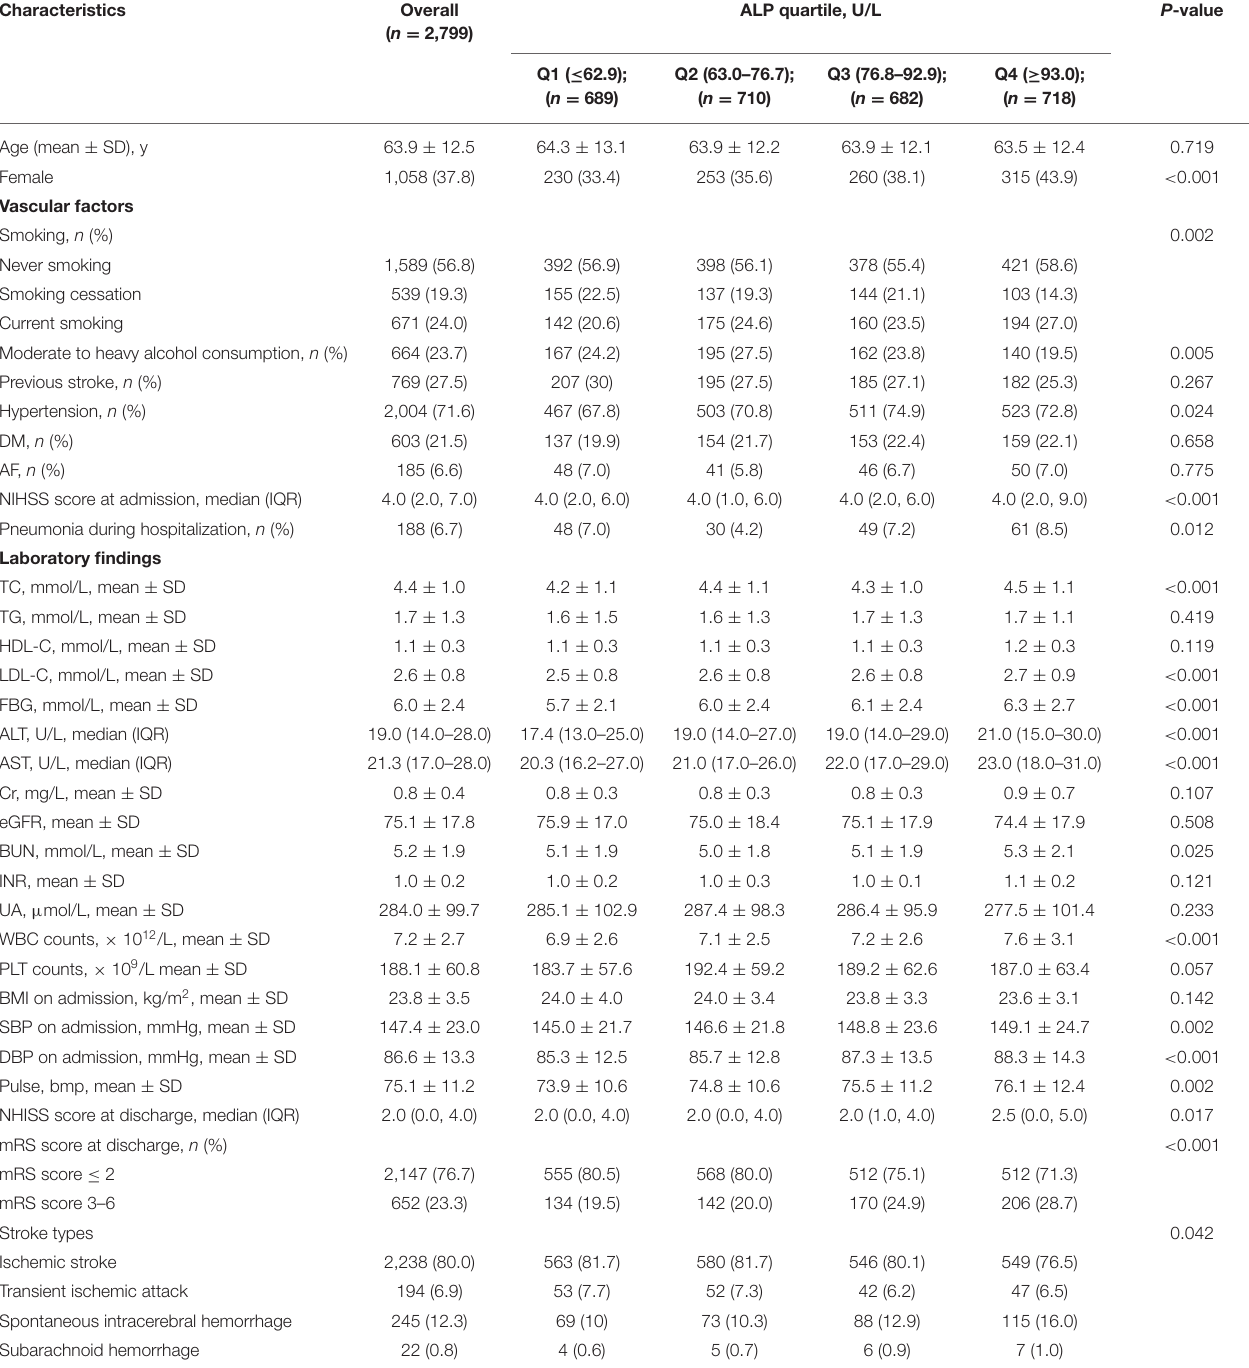
TABLE 1 | Baseline characteristics of the patients according to quartiles of ALP levels.